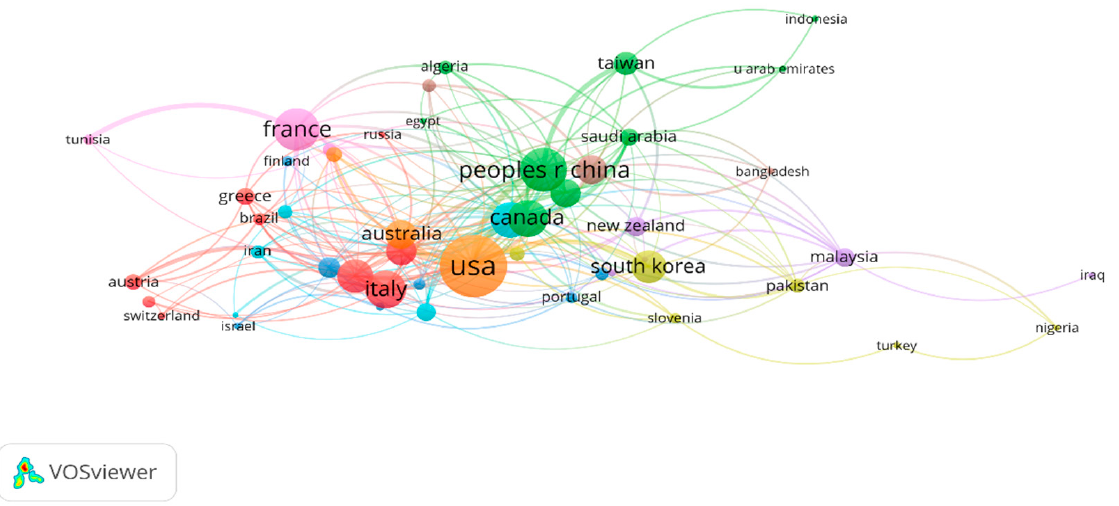
Figure 2. Network visualization by main countries.